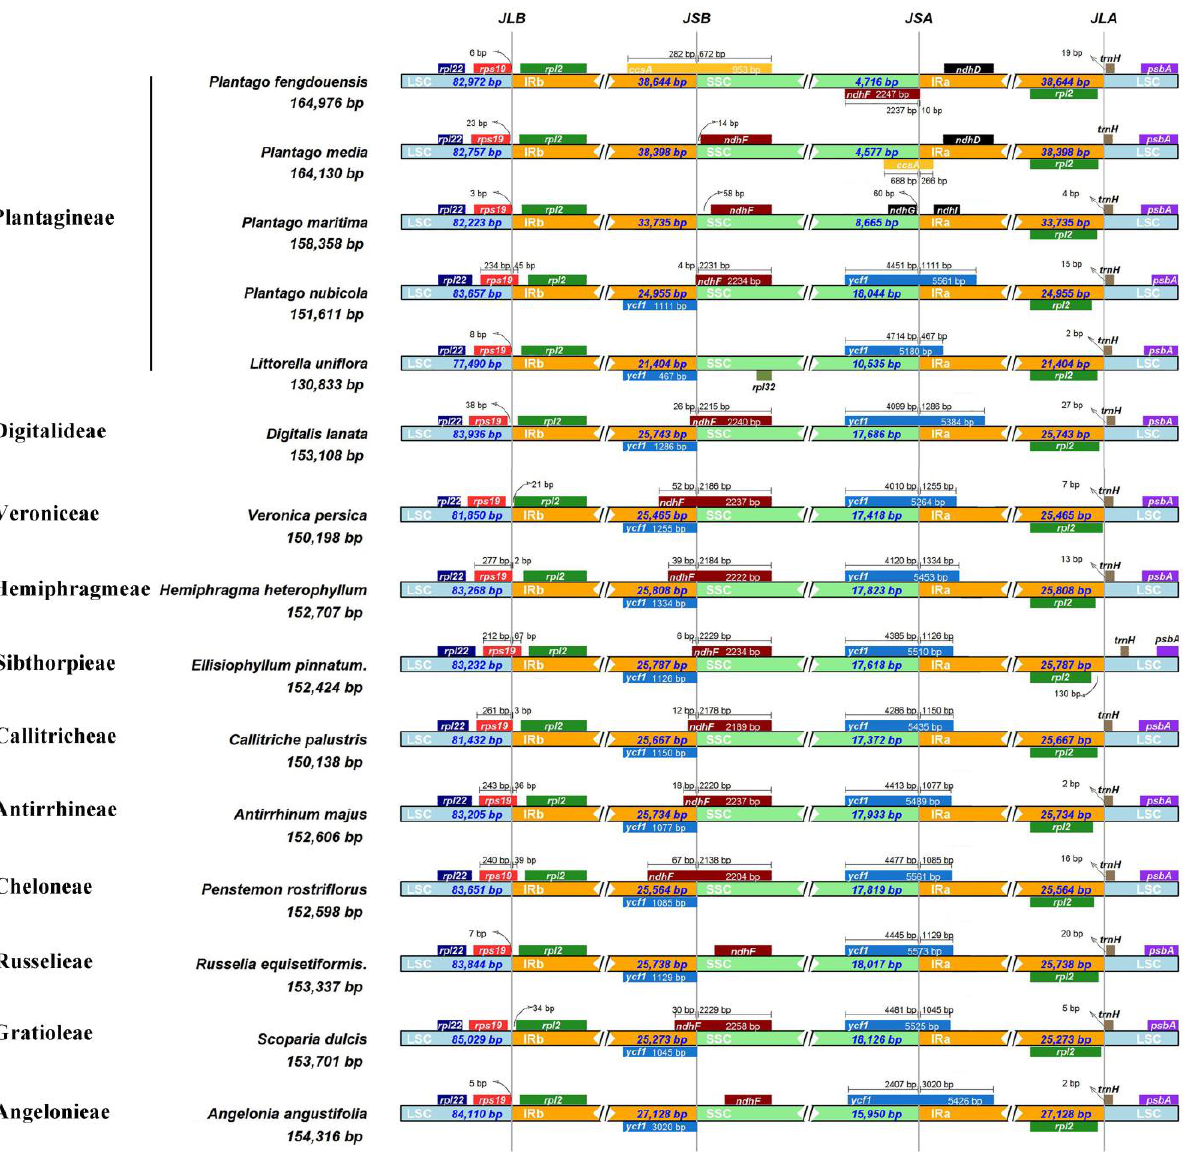
Figure 2. Comparison of the borders of the LSC, SSC, and IR regions of the plastomes from 15 rep- resentative species of Plantaginaceae. JLB: junction line between LSC and IRb; JSB: junction line between IRb and SSC; JSA: junction line between SSC and IRa; JLA: junction line between IRa and LSC.